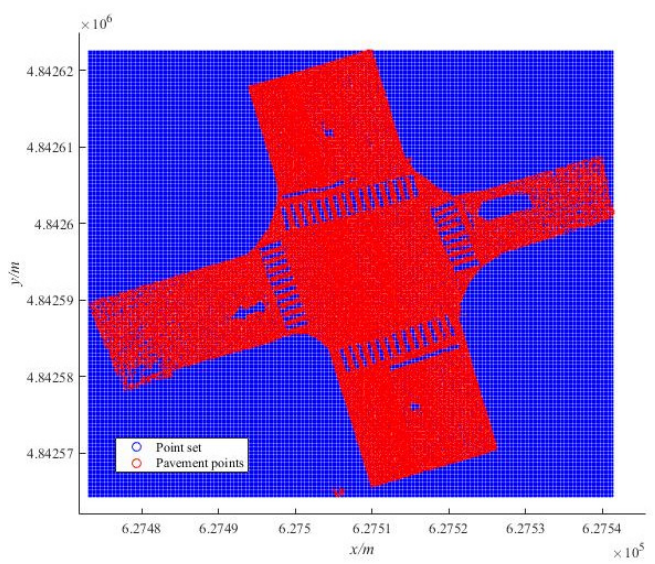
Figure 8. Generated point set.